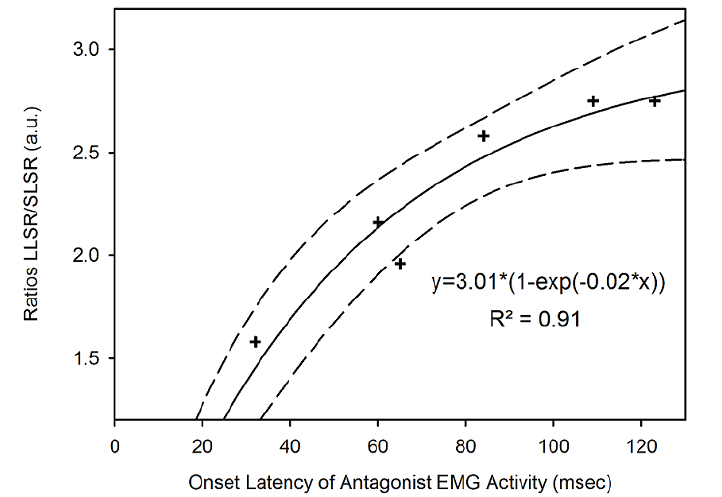
Figure 8. Fitting of the relationship between onset latency of antagonist EMG activity and the ratios LLSR/SLSR during fast pointing movements (FPM) towards an aimed target of 0.2 rad in cerebellar patients. Medium dash: 95% confidence